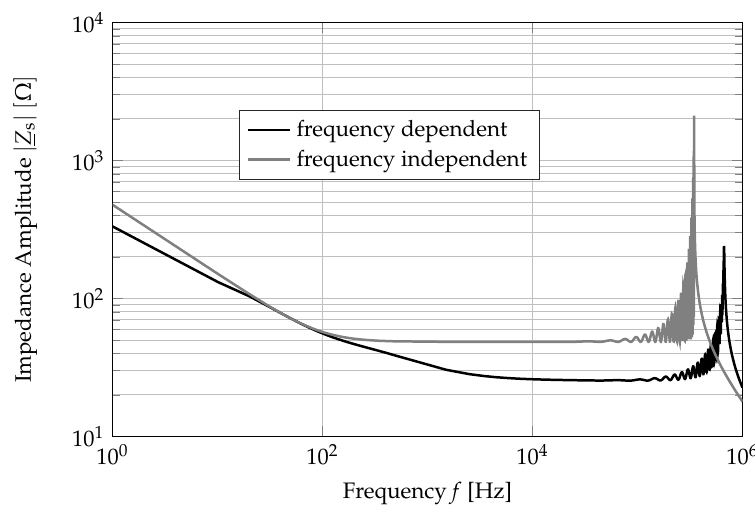
Figure 5. Amplitude of cable impedance at sending end with and without considering the frequency dependence (traditional and developed 3P-PI-Model), n PI = 20, (cid:96) =